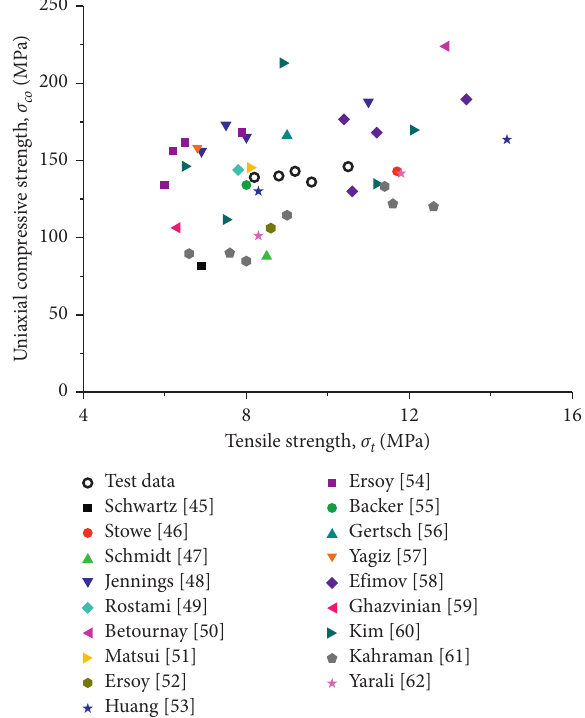
Figure 9: Comparison between the mortar and granite based on brittleness index σ